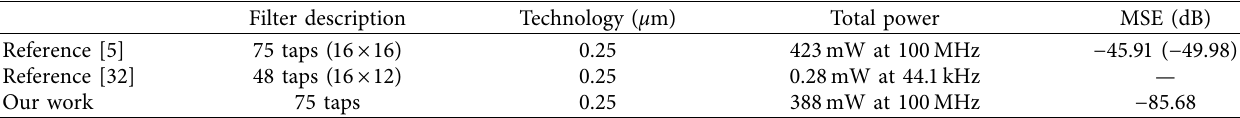
Table 7: Comparison of power reduction of the proposed filter with previous